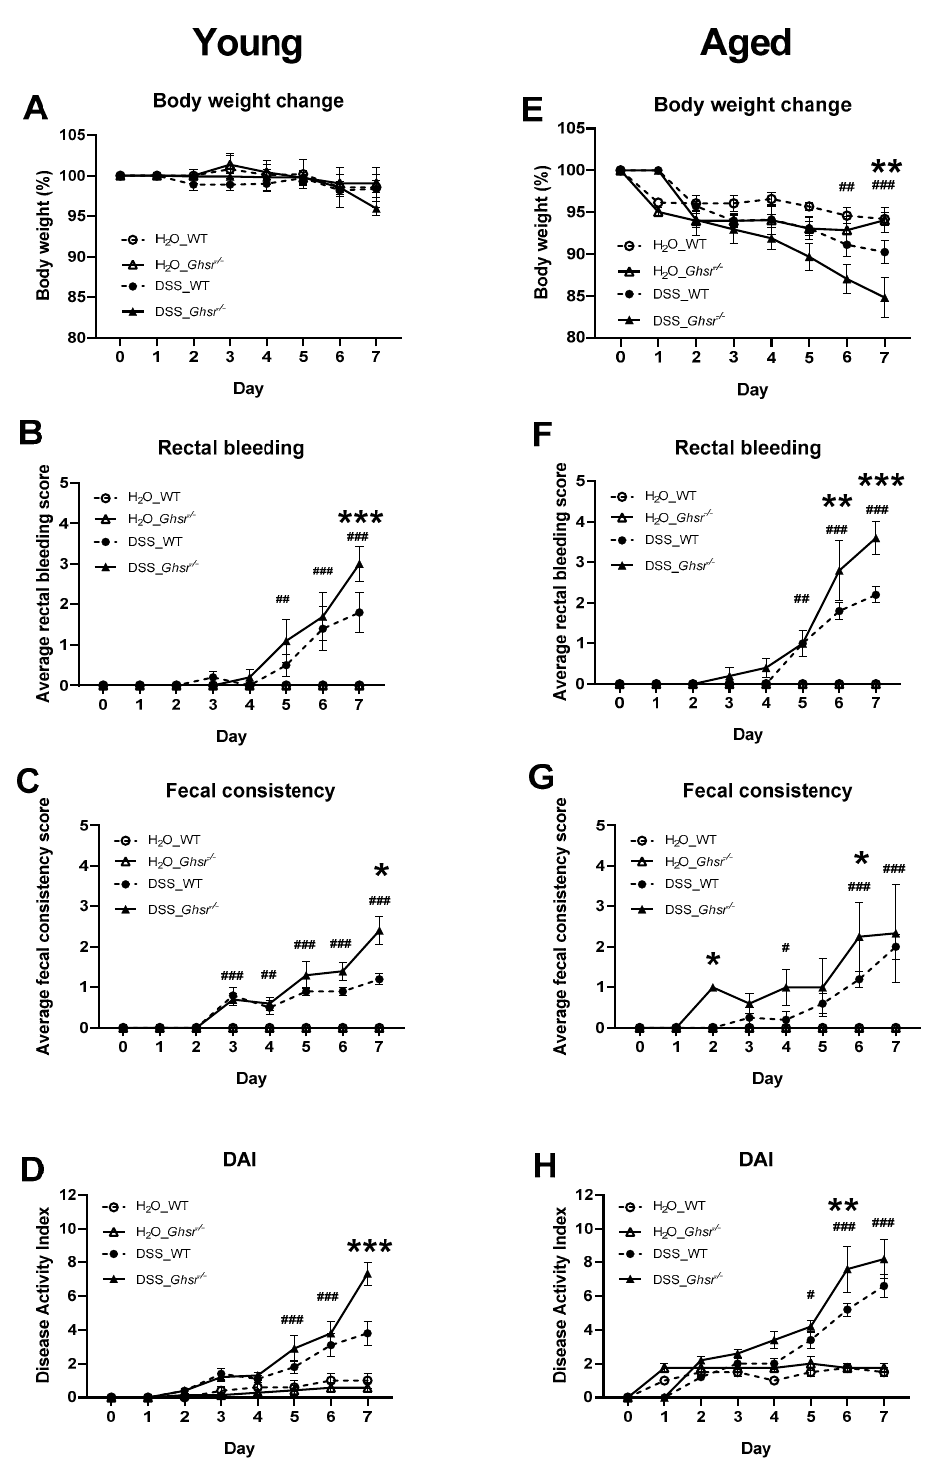
Figure 2. Young and aged GHS-R KO showed exacerbated colitis. Young (4–6-month-old) or old (18-month-old) male mice were exposed to 2% ( w / v ) DSS for 7 consecutive days. The left panels are from the young group and the right panels are from the old group. ( A , E ) Body weight change (%), ( B , F ) rectal bleeding, ( C , G ) fecal consistency, ( D , H ) disease activity index (DAI) scored by sum of body weight change, fecal consistency, and rectal bleeding. n = 5–10 in young group, n = 4–5 in aged group. * p < 0.05, ** p < 0.01, *** p < 0.001 WT vs. Ghsr − / − . #, p < 0.05, ##, p < 0.01, ### p < 0.001 DSS vs. normal water in each genotype.